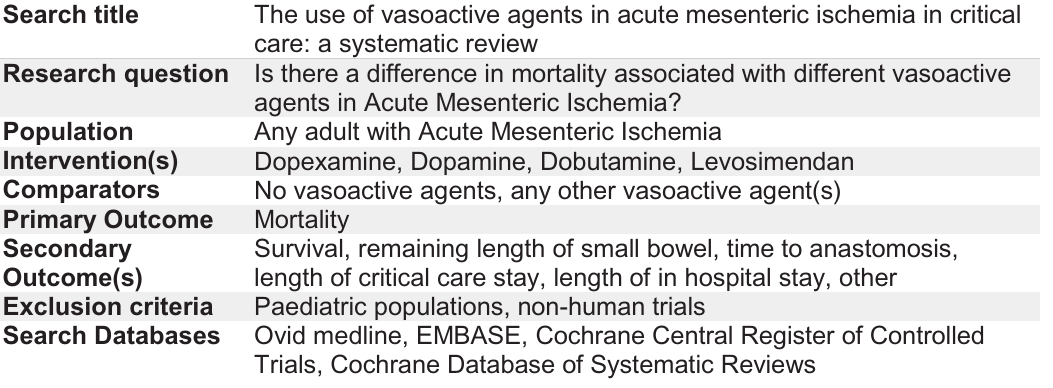
Figure 1. Summary of study